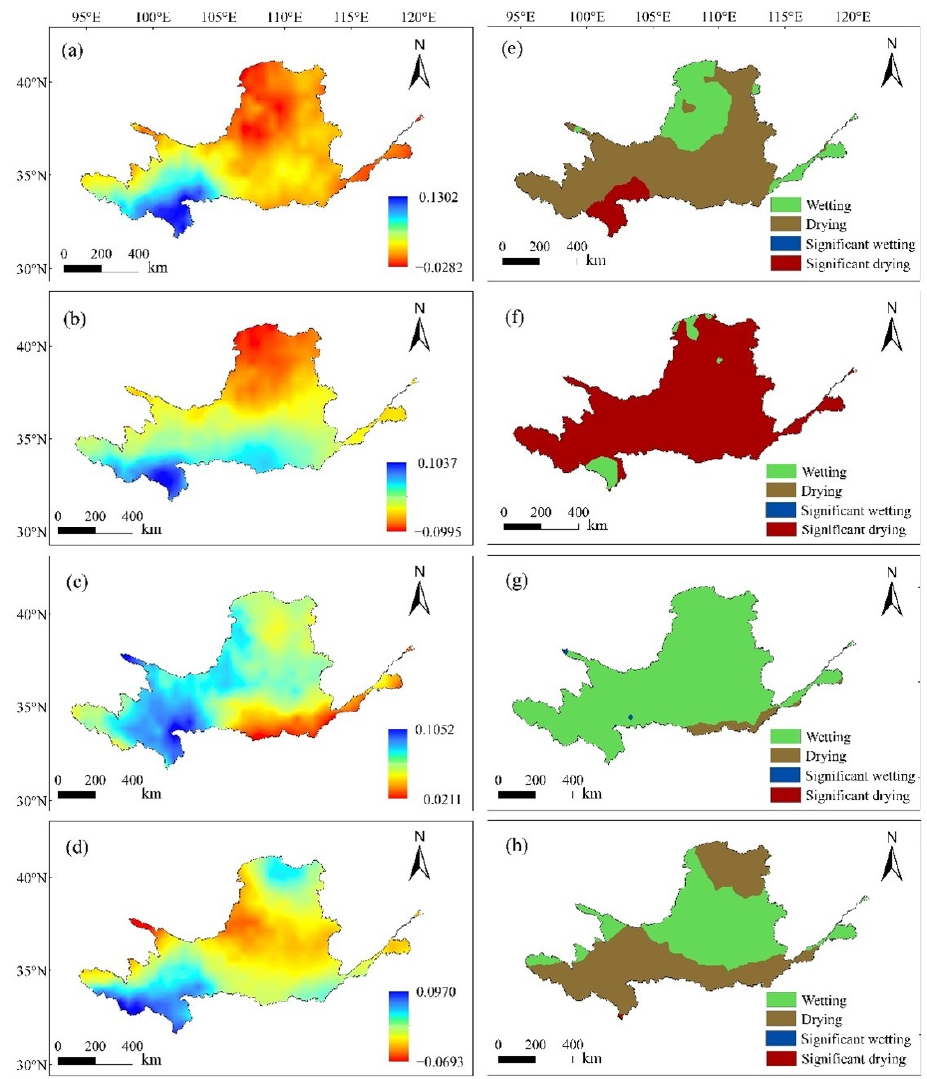
Figure 5. Spatial characteristics of SPEI variation trend ( a : Annual; b : Spring; c : Summer; d : Autumn) and significance ( e : Annual; f : Spring; g : Summer; h : Autumn) in annual and different seasons ( p < 0.05).